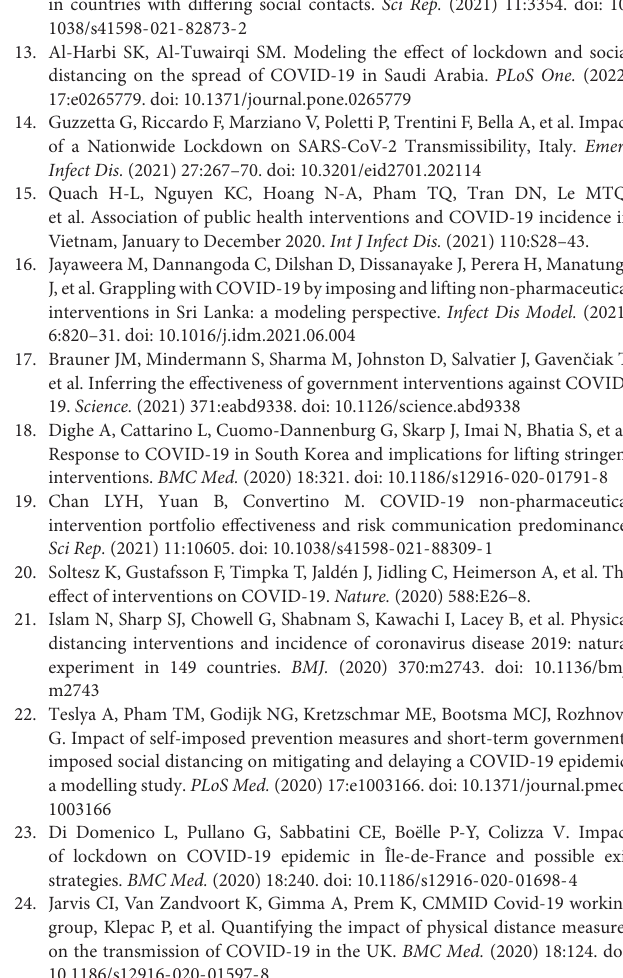
who are hospitalized or under observation at home. Twenty or more cases per 100,000 population in a prefecture is defined as stage 3, and 30 or more cases is defined as stage 4. (D) The daily PCR-positivity rate is defined as stage 3 with 5% or more positive test results among the total tests and stage 4 with 10% or more. (E) The daily number of newly reported cases is defined as stage 3 with 15 or more newly reported cases per 100,000 population and stage 4 with 25 or more newly reported cases per 100,000. (F) The percentage of unlinked cases is defined as 50% or more for stage 3 and less than 50% for stage 2. The left-hand panel shows the absolute reduction in the effective reproduction number ( R t ) and the right-hand panel shows the relative reduction. We calculated p-values using analysis of variance or the Wilcoxon signed-rank test. Supplementary Figure 3 | Google mobility: retail and recreation percent change from baseline during and before intervention. The broken line shows the retail and recreation percent change from baseline for mobility provided by Google. The relative change in time spent compared with that at the baseline of January 2020 is shown. The blue shading in the figure indicates pre-emergency measures (PEM), the red shading indicates state of emergency (SoE), the yellow shading indicates PEM 1 week earlier, and the green shading indicates PEM 2 weeks earlier. Panels (A–F) in the figure correspond to Hokkaido, Tokyo, Aichi, Kyoto, Osaka, and Hyogo prefectures, respectively. In (A,D) , mobility appears to have already started decreasing before the intervention. In the other panels, the effect of intervention appears to be working, especially for the